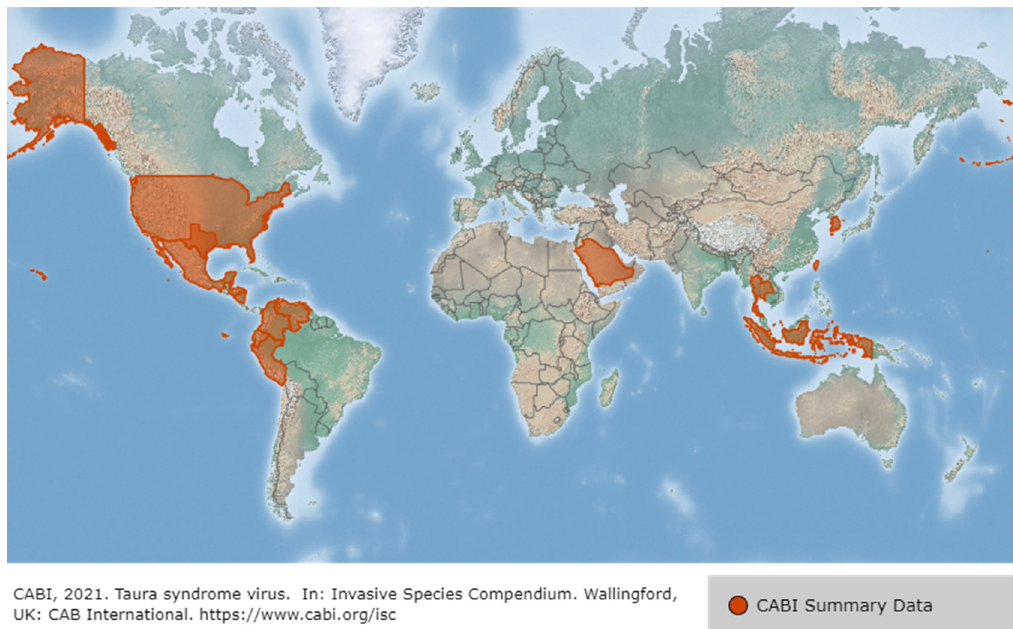
Figure 18. Distribution map showing the geographical occurrence of Taura syndrome virus (TSV) (Reprinted from CABI, 2019, Taura syndrome virus. In: Invasive Species Compendium. Wallingford, UK: CAB International, with permission from CABI).